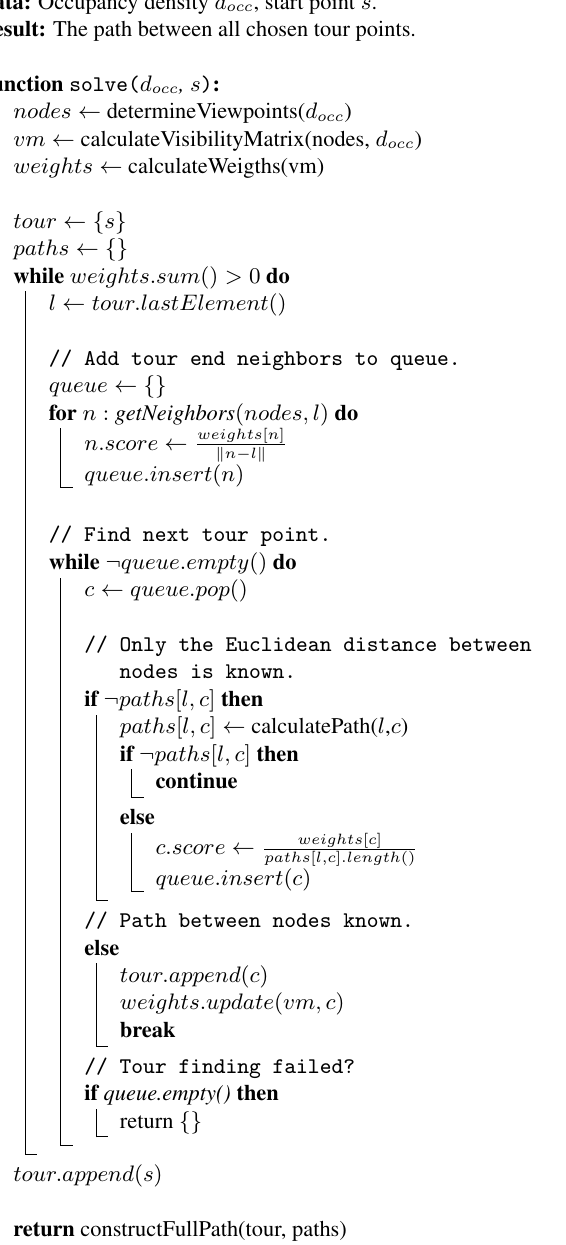
Figure 2. Example scenario illustrating our solution for tour planning. The visibility matrix (a) is used to derive the viewpoint weights vector (left side of b,c,d). In the first iteration (b), point E is chosen, since it is the nearest one with the highest score. The second iteration (c) leads to the choice of point G, after which the algorithm terminated, since the viewpoint weights vector is zero and all points have been observed (d). Algorithm 2: Update of the viewpoint weights Algorithm 1: Nearest neighbor based solving of the Dynamic Graph Traveling Salesman Problem.